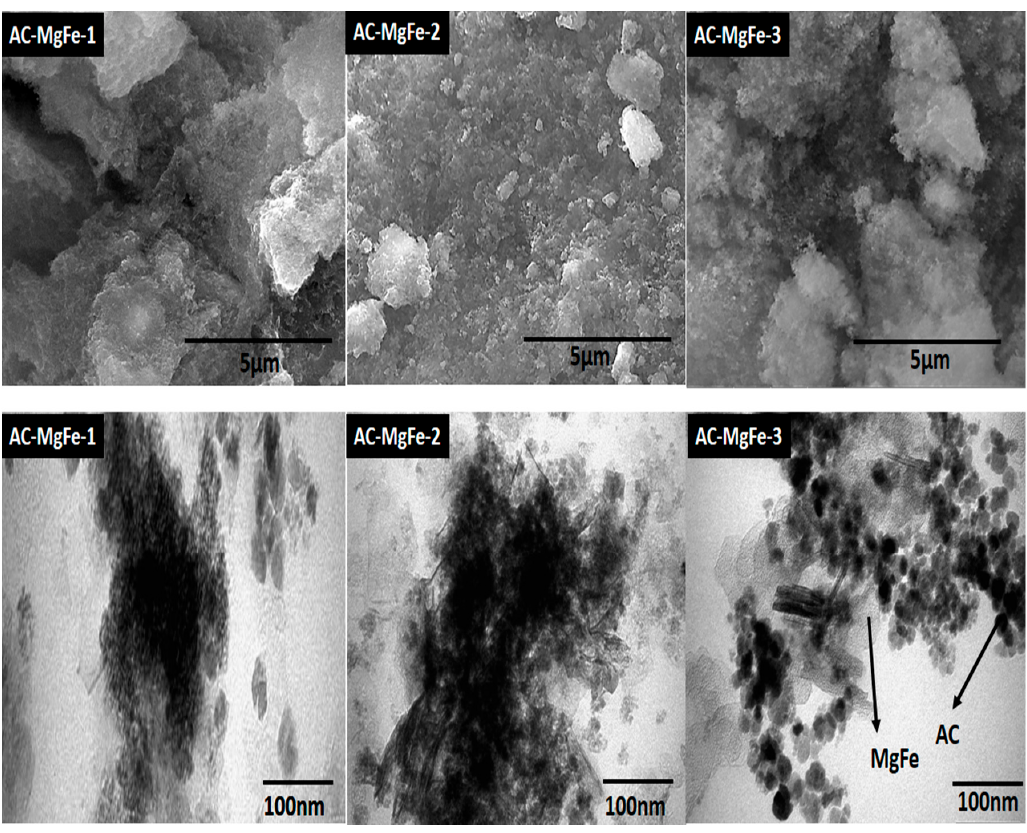
Figure 2. SEM and TEM images of AC–MgFe composites.